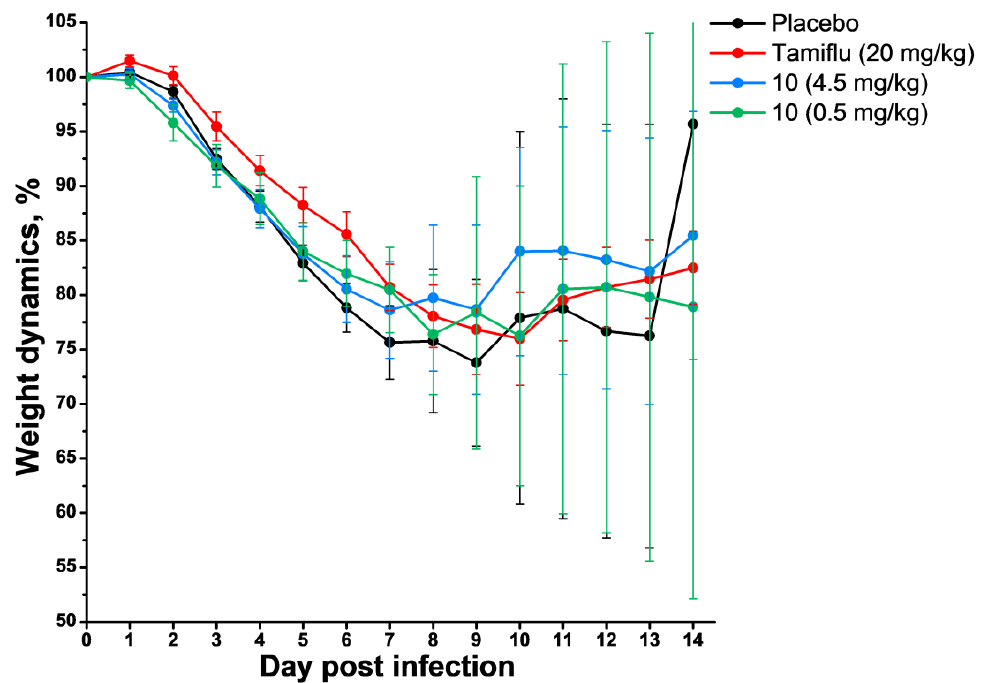
Figure 1. Kaplan – Meier survival curves during experimental influenza pneumonia in BALB/c mice upon infection with influenza A/California/7/09/MA virus (N = 10); * — difference between Placebo and Tamiflu groups is statistically significant ( p = 0.02084).